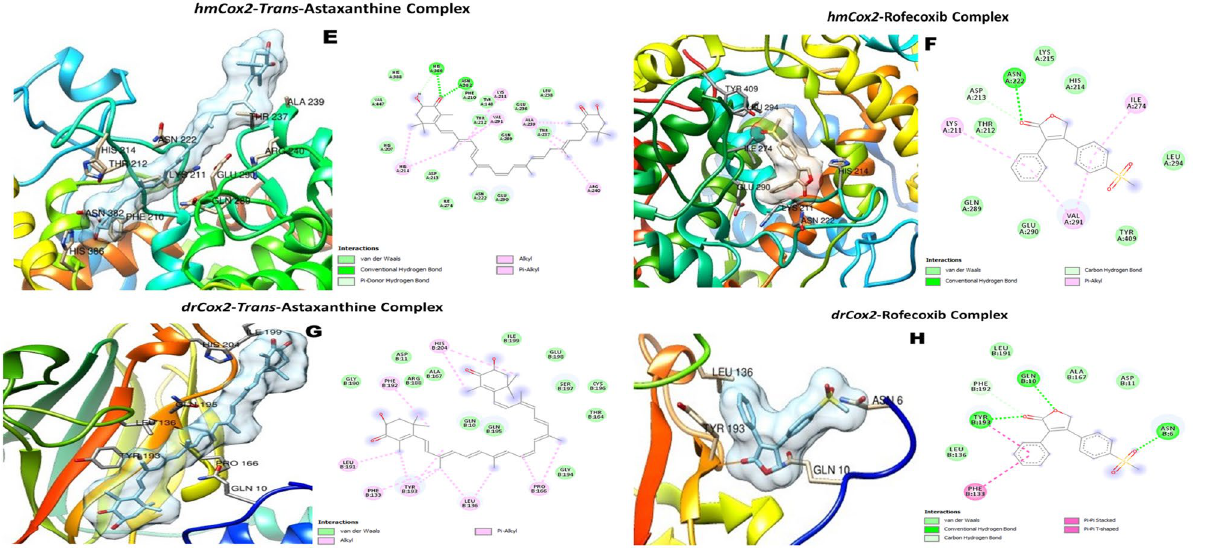
Figure 7. The 3D and 2D molecular complexations of Human Cox2 (hmCox2) with TA ( E ) and Rofecoxib ( F ); and Drosophila Cox-2 (drCox-2) with TA ( G ) and Rofecoxib ( H ) respectively.